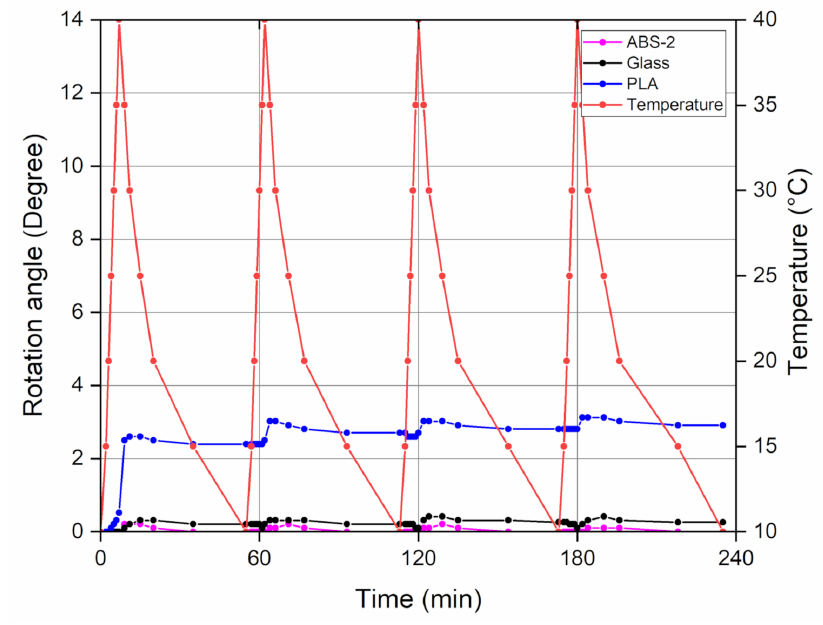
Figure 7. The rotation angle variations of all bolted joints under cyclical temperature changes from 10 ◦ C to 40 ◦